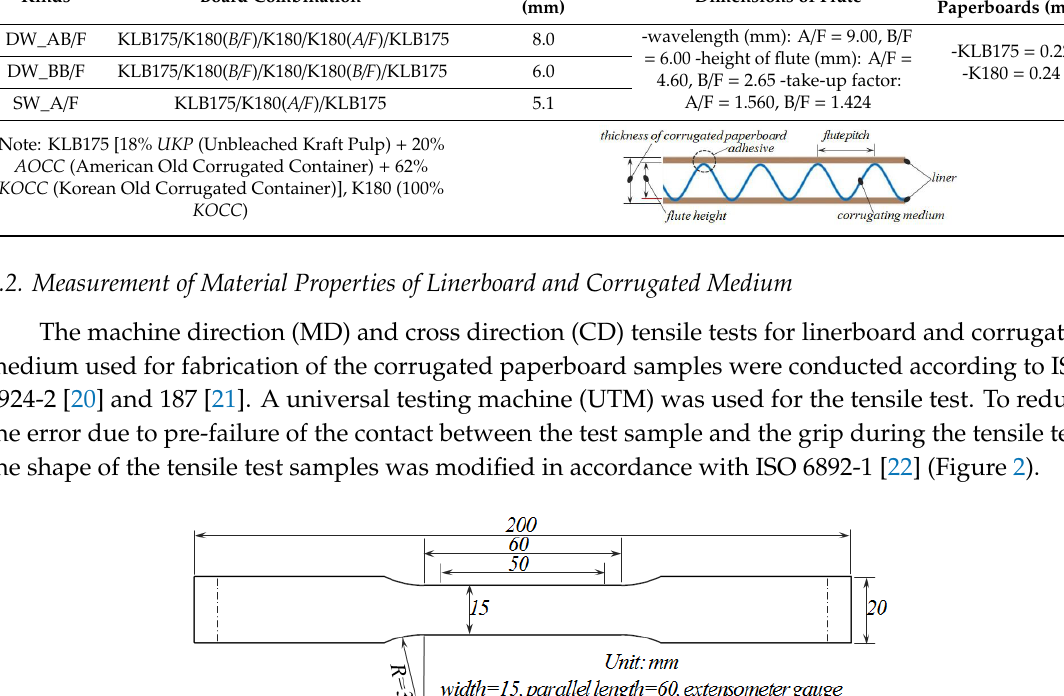
Figure 2. Detailed dimensions of tensile test specimen used in the study.